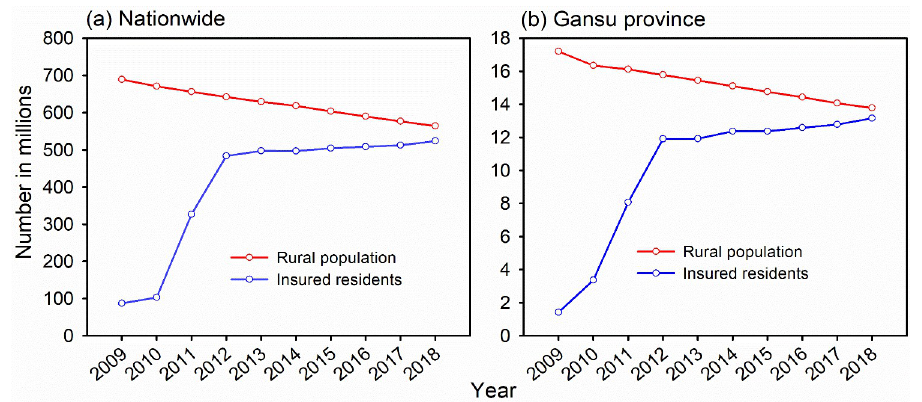
Fig 1. Trends in rural population and coverage of NRPS in China (a) and Gansu Province (b). Data source: China Statistical Yearbook.